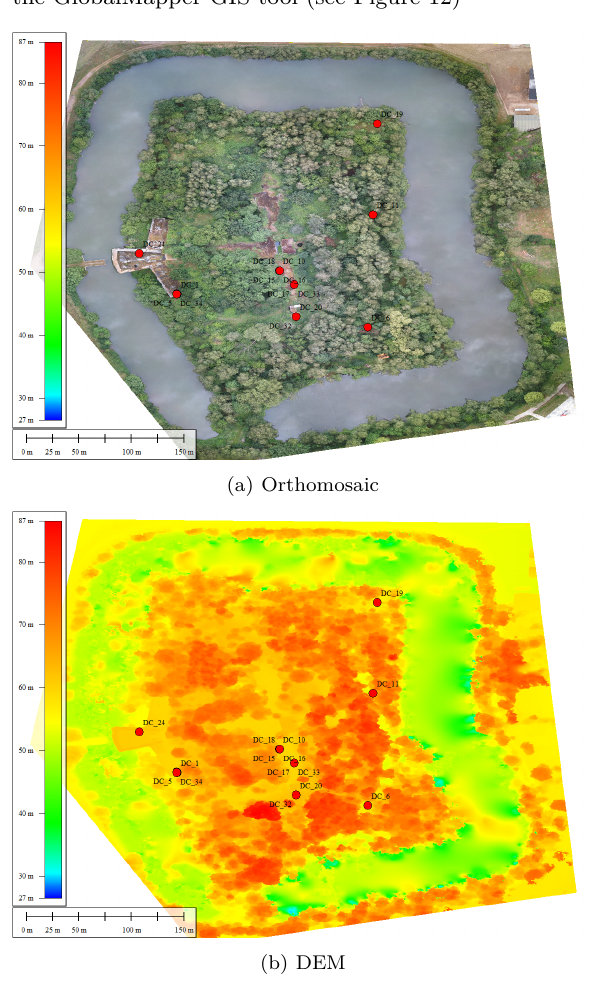
Figure 12. Flight 2 visualized with GlobalMapper. The dots represent dummy